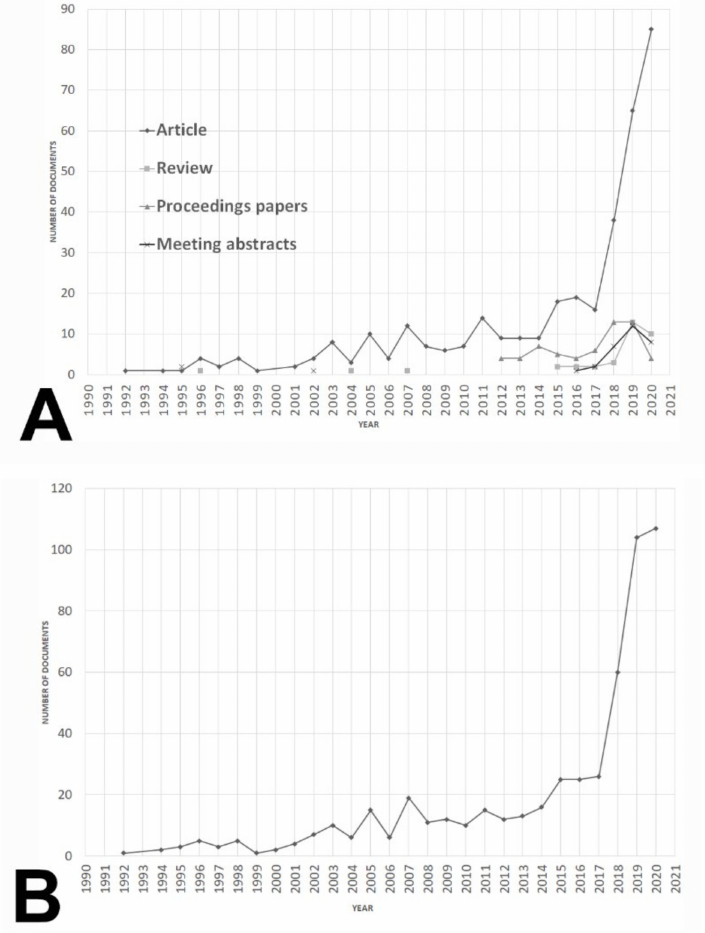
Figure 1. Evolution of documents referred to AI and ML applications to diagnostic pathology in lymphoid neoplasms from 1990 to 2020. ( A ) Document production trends referred to AI and ML applications to diagnostic pathology in lymphoid neoplasms according to document type (original article, review, proceeding papers, and meeting abstracts) from 1990 to 2020. ( B ) Global production trends of documents referred to AI and ML applications to the field of diagnostic pathology in lymphoid neoplasms from 1990 to